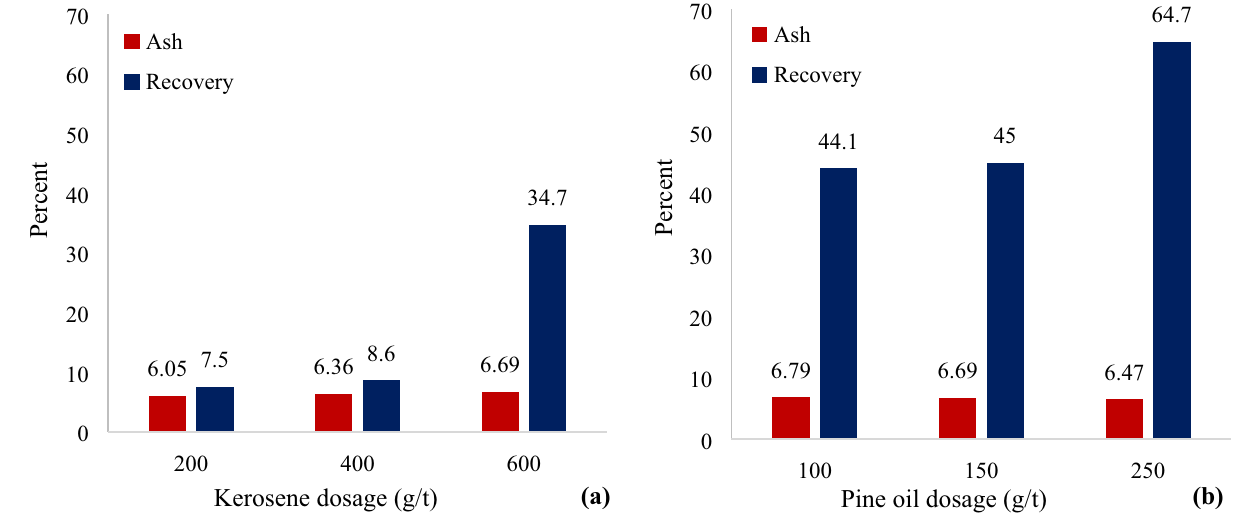
Figure 6. Diagrams of ash content and recovery of gilsonite flotation concentrate at concentrations of ( a ) 200, 400 and 600 g/t of kerosene collector and ( b ) 100, 150 and 250 g/t of pine oil